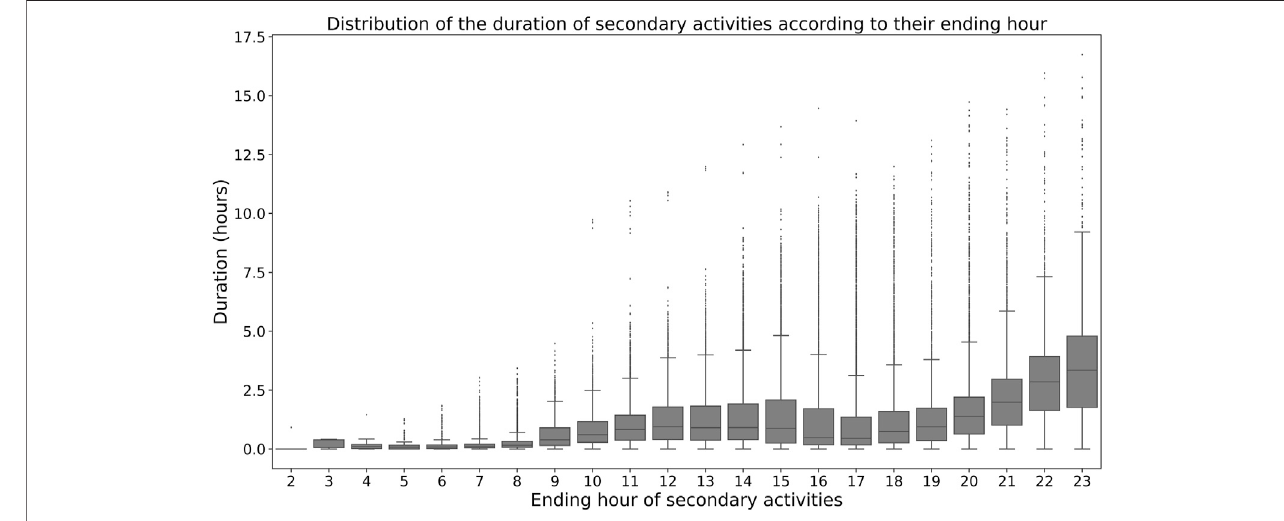
FIGURE 14 | Duration of secondary activities according to their ending